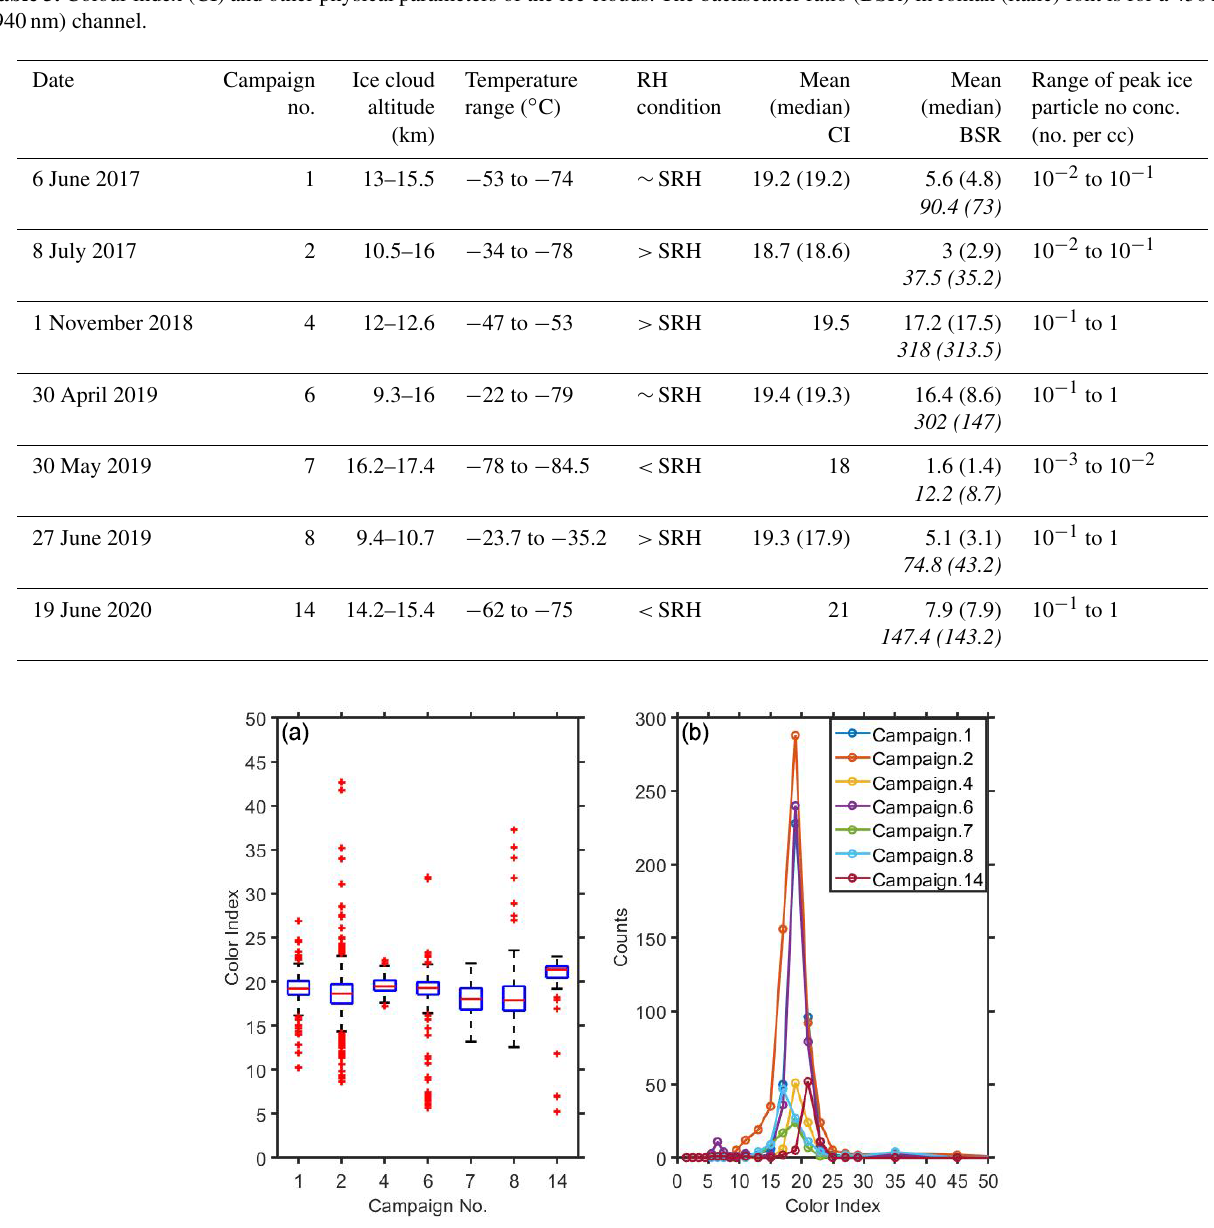
Figure 12. (a) Box plot of the colour index (CI) observed for the ice clouds found in different campaigns. The horizontal line in the centre of the box represents the median. The upper and lower edges of the box represent the third quartile ( Q 3) and first quartile ( Q 1), respectively. Similarly, the upper and lower whiskers represent Q 3 + 1 . 5 × (Q 3 − Q 1 ) and Q 1 − 1 . 5 × (Q 3 − Q 1 ) , respectively. The data points beyond the whiskers (outliers) are shown with red star symbols. (b) The histogram of the CI values from each campaign. Different colours indicate the data from different